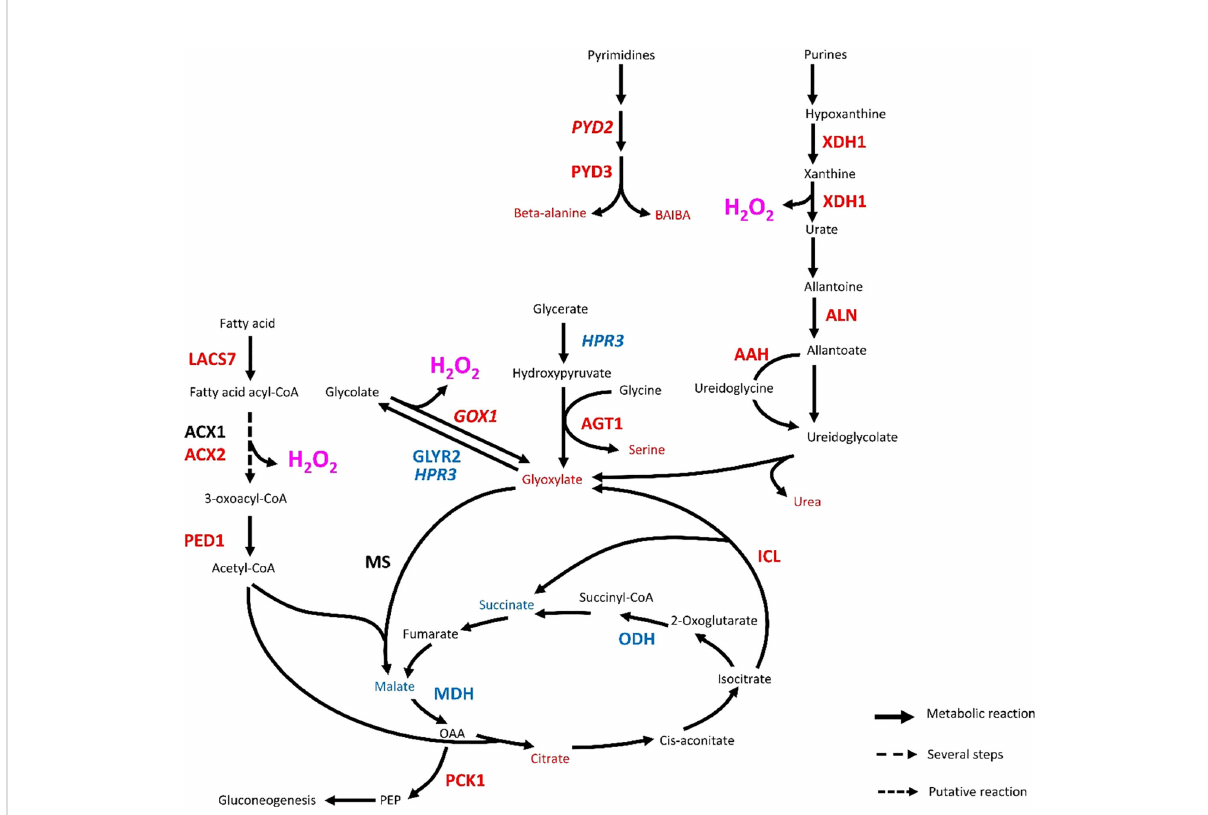
FIGURE 7 Transcriptional regulation of glyoxylate metabolic pathways in Rubira 48 hours after infestation with GPA. Genes are annotated according to their Arabidopsis orthologs, non-orthologs (homologs) are noted in italics. Upregulated genes/metabolites are fi gured in red, downregulated genes/metabolites in blue and not found or not differentially expressed genes/metabolites in black. AAH, Allantoate deiminase; ACX1, Peroxisomal acyl-coenzyme A oxidase 1; ACX2, Acyl-coenzyme A oxidase 2; AGT1, Glyoxylate aminotransferase 1; ALN, Allantoinase; GLYR2, Glyoxylate/succinic semialdehyde reductase 2; GOX1, Glycolate oxidase; HPR3, Glyoxylate/hydroxypyruvate reductase; ICL, Isocitrate lyase; LACS7, Long chain acyl-CoA synthetase 7; MDH, malate dehydrogenase; MS, Malate synthase; ODH, Oxoglutarate dehydrogenase; PCK1, Phosphoenolpyruvate carboxykinase 1; PED1, 3-ketoacyl-CoA thiolase 2, peroxisomal; PYD2, Dihydropyrimidinase; PYD3, Beta- ureidopropionase; XDH1, Xanthine dehydrogenase 1; BAIBA, Beta-aminoisobutyrate; PEP, Phosphoenol